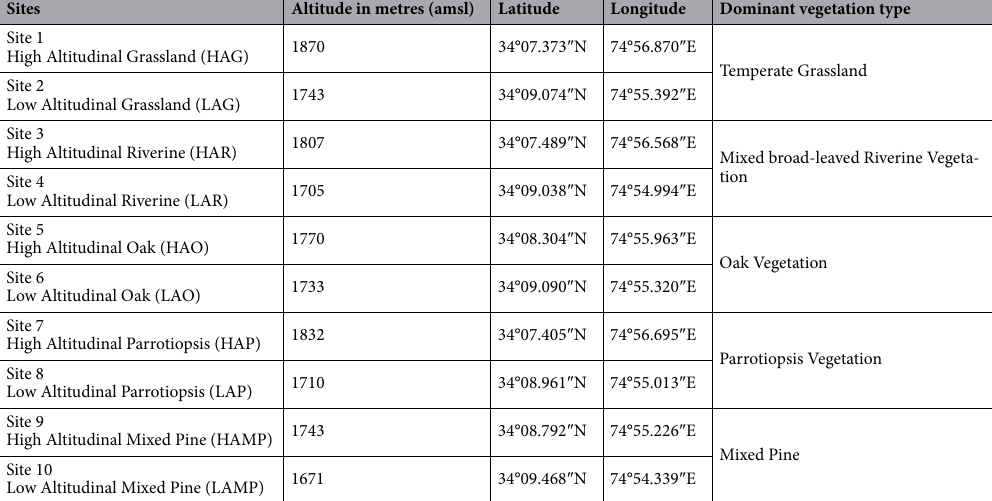
Sites Altitude in metres (amsl) Latitude Longitude Dominant vegetation